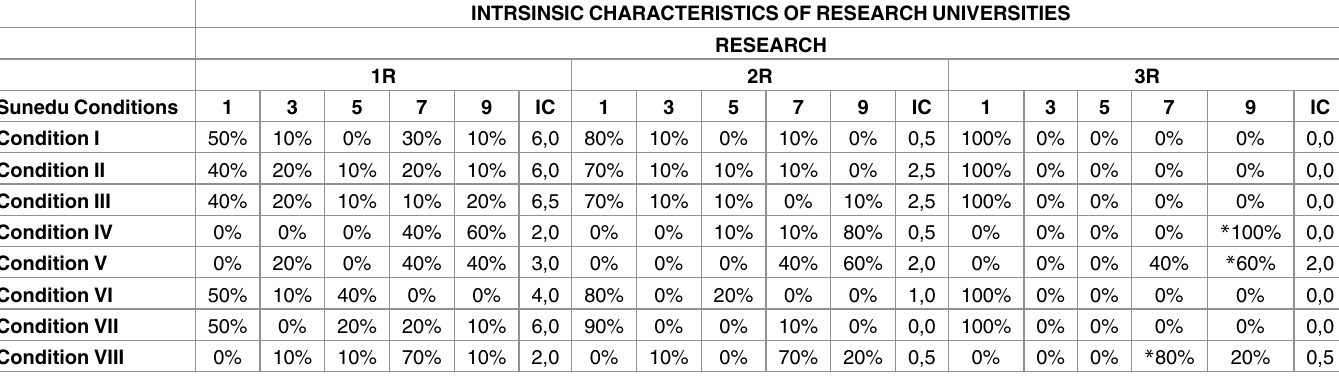
Table 3. Results of the Sunedu-Research